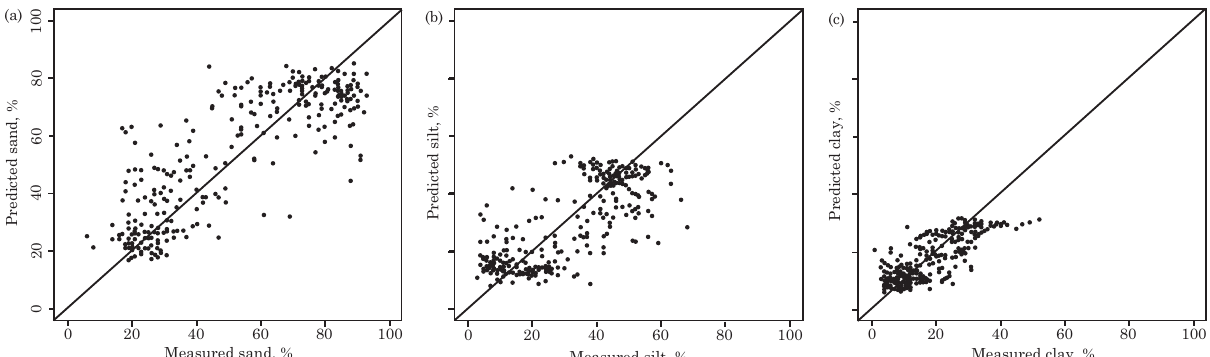
Figure 3. Measured and predicted particle size-fractions using the predictive models PMs-1: (a) sand, (b) silt, and (c)